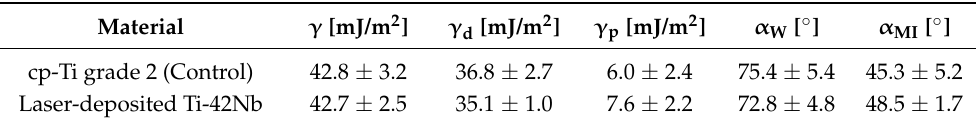
Table 2. Surface free energy of samples ( γ ), dispersive component ( γ d ), polar component ( γ p ), contact angle with water ( α W ), and contact angle with diiodomethane ( α MI ).